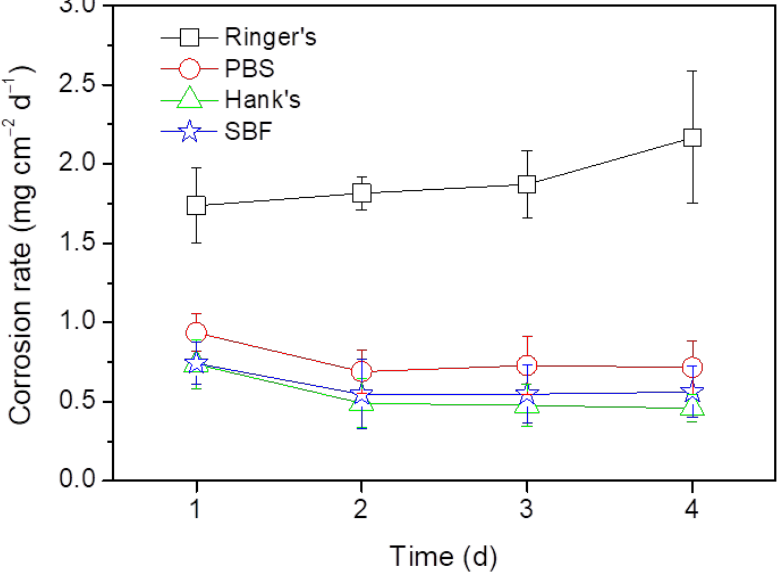
Figure 3. Time evolution of the corrosion rates of the AZ31B Mg alloy in Ringer’s, PBS, Hank’s, and SBF solutions at 37 ◦ C obtained from weight loss measurements.